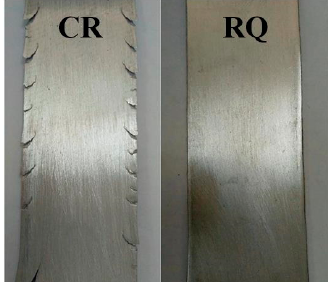
Figure 2. 6061 sheets after solution treatment + water quenching+ 60% cold rolling (CR) and the 60% hot rolling-quenching integrated process (RQ).